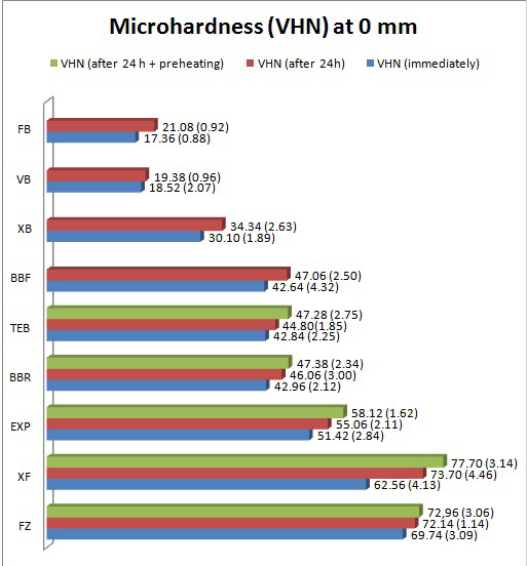
Figure 1. Mean values and standard deviations of microhardness expressed in VHN of all the experimental groups at 0 mm depth (top